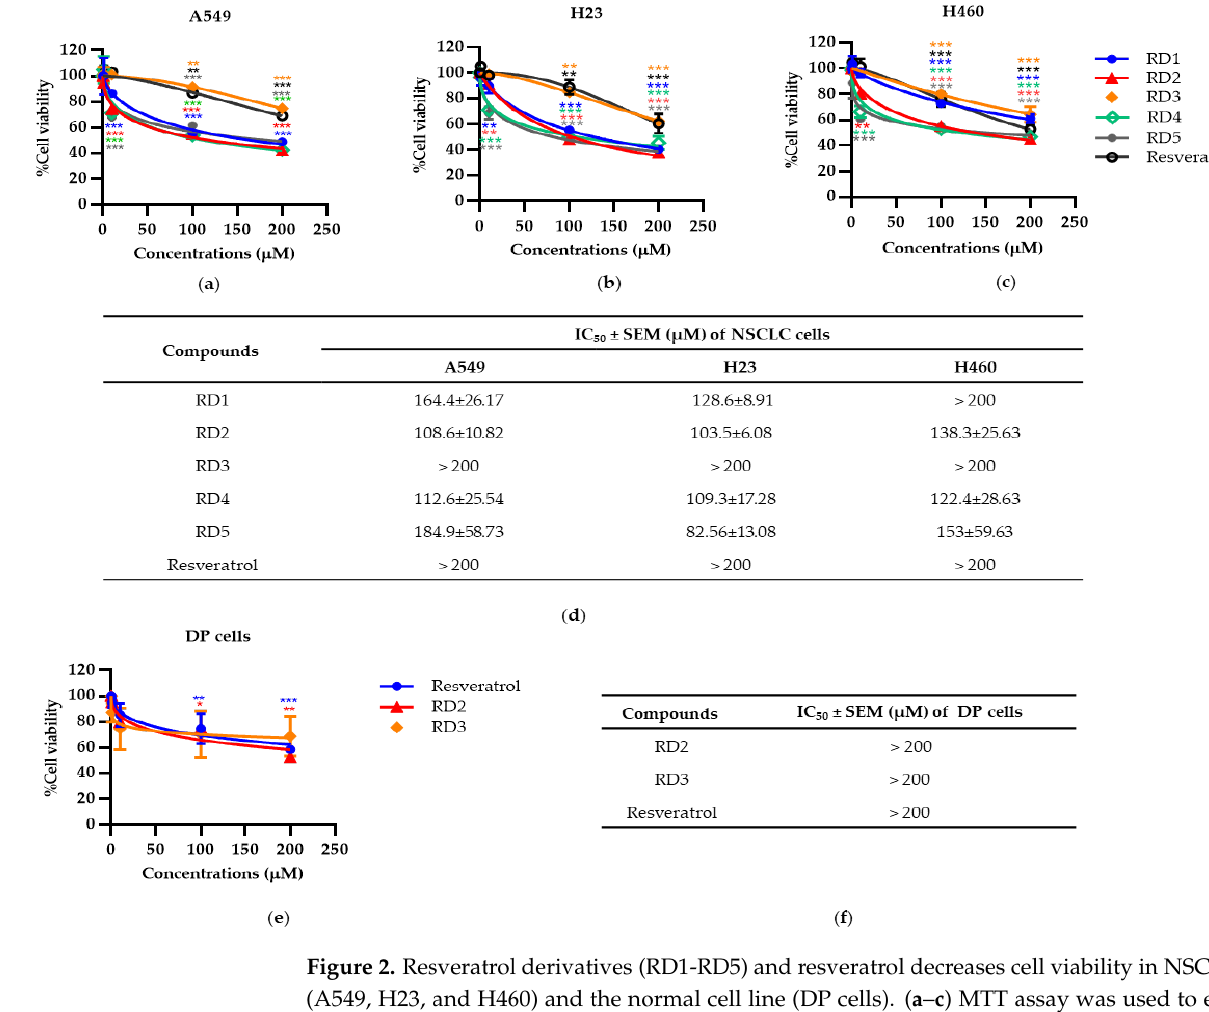
Figure 2. Resveratrol derivatives (RD1-RD5) and resveratrol decreases cell viability in NSCLC cells (A549, H23, and H460) and the normal cell line (DP cells). ( a – c ) MTT assay was used to evaluate cell viability after treatment with various concentrations of RD1-RD5 and resveratrol (0–200 mM) for 24 h in A549, H23, and H460 cells, respectively. ( d ) The IC 50 of RD1-5 and resveratrol against A549, H23, and H460 cells was calculated from MTT assay by comparison with an untreated control. ( e ) MTT assay was used to evaluate cell viability after treatment with various concentrations of RD2, RD3, and resveratrol (0–200 mM) for 24 h in DP cells, respectively. ( f ) The IC 50 of RD2, RD3, and resveratrol against DP cells was calculated from MTT assay by comparison with an untreated control. Data are represented as the mean ± SEM. * p < 0.05, ** p < 0.01, *** p < 0.001 when compared with